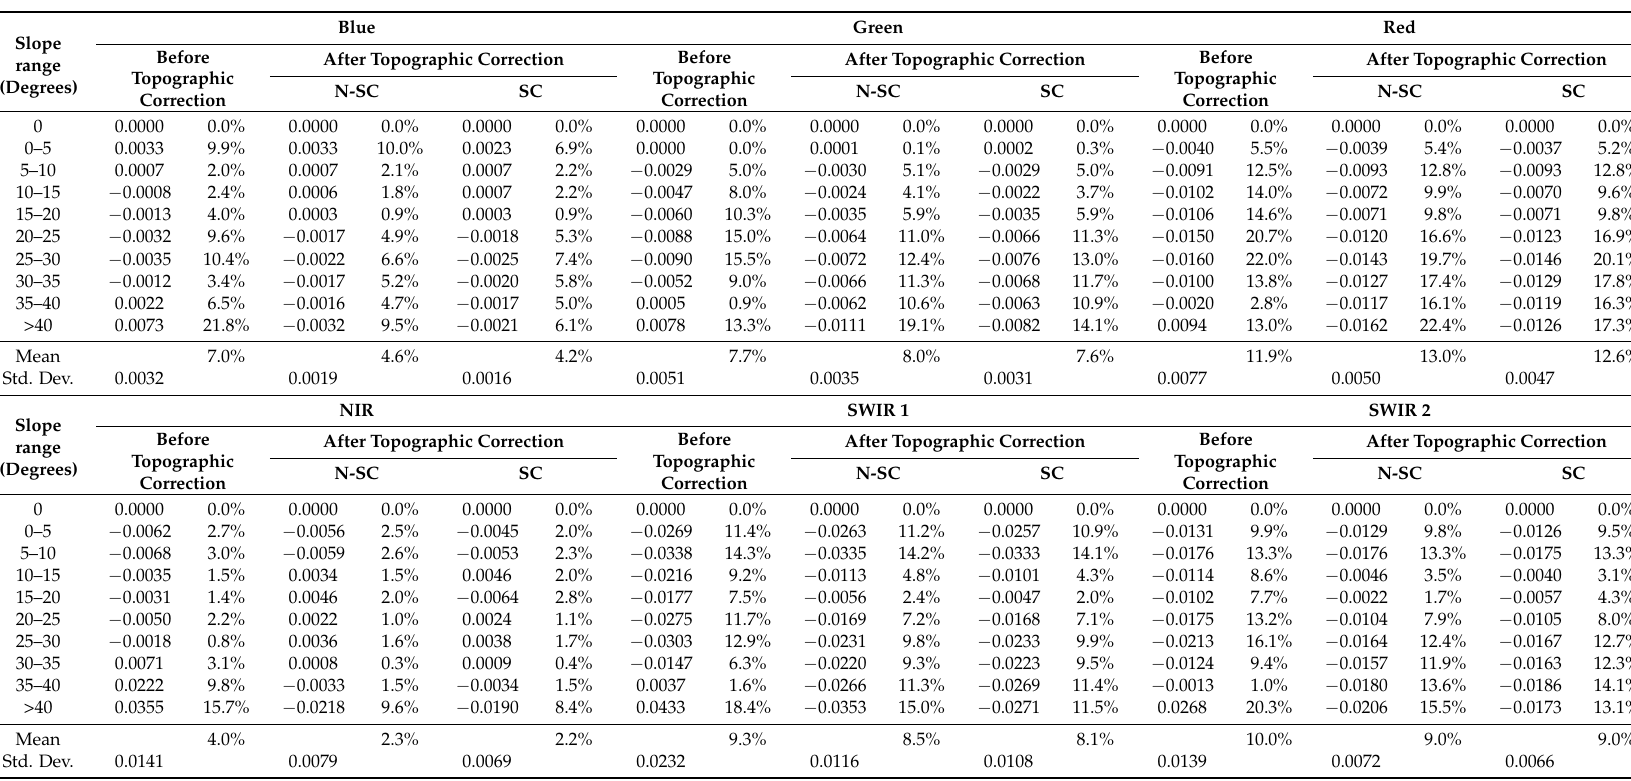
Table 3. Absolute and relative reflectance differences between the mean reflectance of each slope class and mean reflectance of flat terrain, for oak, pine, and mesophyll forest. Image: Landsat OLI from 7 March